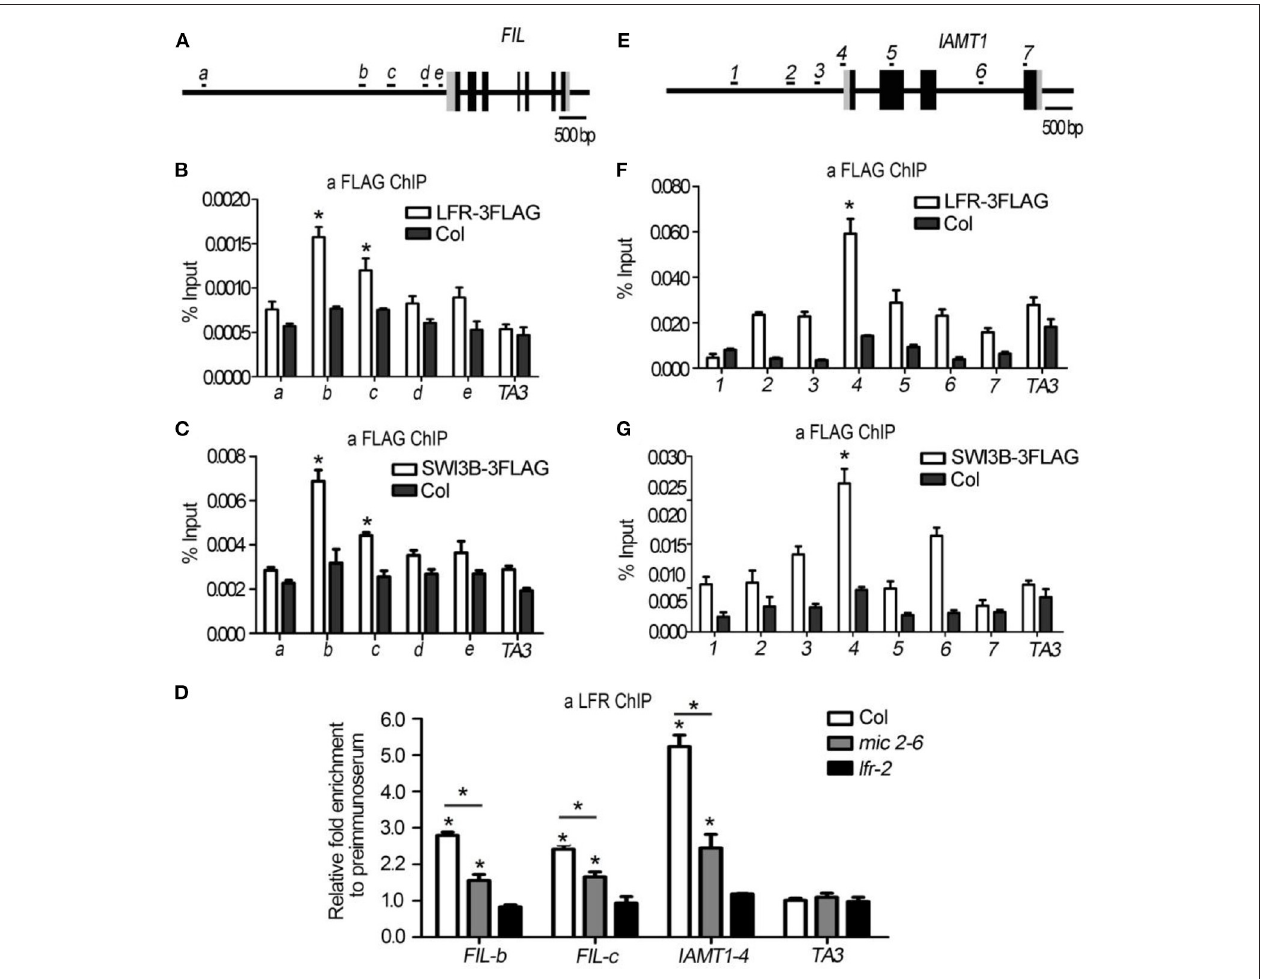
FIGURE 7 | LFR and SWI3B are associated with the chromatin of FIL and IAMT1 . (A,E) The diagrams of FIL and IAMT1 gene structures. The black boxes indicate exons, the gray boxes indicate untranslated regions and the long black lines represent the upstream sequence or promoter, introns regions, or 3 ′ -terminal sequence. The lowercase letters (A) or the numbers (E) and black short lines above the gene structures represent PCR fragments tested in ChIP-qPCR (B–D,F,G) . (B,F) ChIP-qPCR assay to test the association of LFR-3FLAG with FIL (B) and IAMT1 (F) chromatin using anti-FLAG antibody. (C,G) ChIP-qPCR assay to test the association of SWI3B-3FLAG with FIL (C) and IAMT1 (G) locus using anti-FLAG antibody. (D) ChIP-qPCR assay to test the association of LFR to FIL chromatin using the anti-LFR antibody in mic2-6 . The bars represent the means of three independent biological repeats and the error bars stand for SE. Significant statistical differences were tested by Student’s t -test (* P < 0.05). A retrotransposon locus TA3 ( At1g37110 ) was used as the negative control in ChIP-qPCR (B–D,F,G)